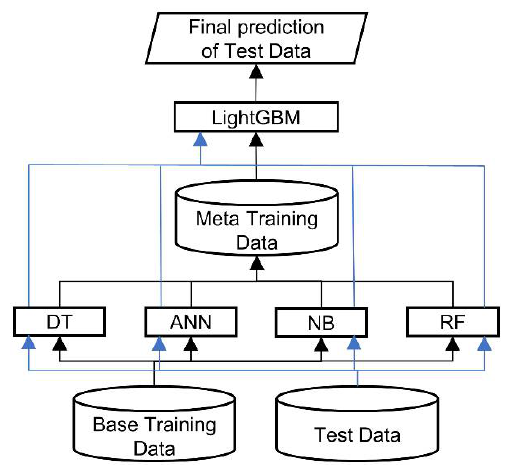
Figure 10. Architecture of